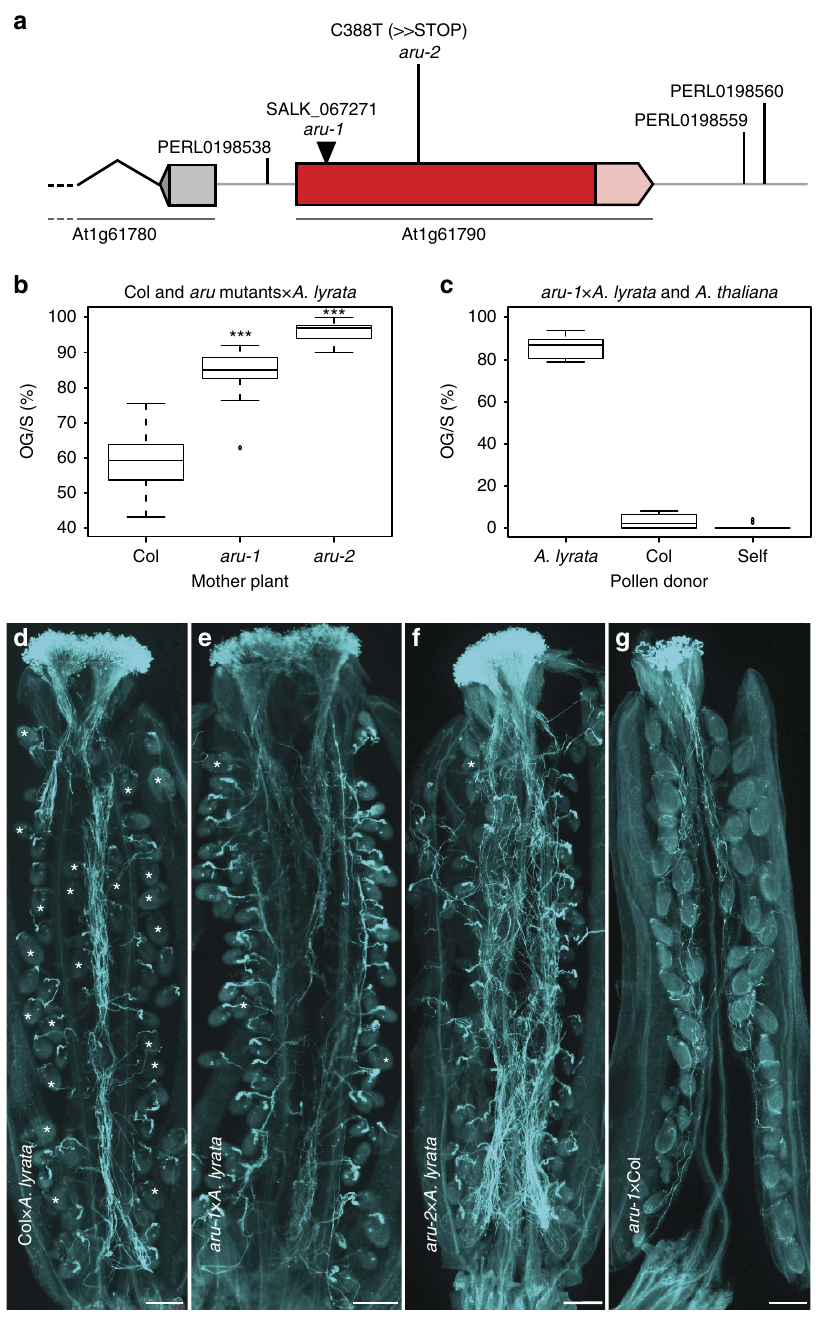
Figure 4 | ARTUMES mutants are impaired in interspecific PT reception. ( a ) Genomic region of ARTUMES (At1g61790) with the two mutant alleles aru-1 and aru-2 , and the surrounding polymorphisms identified by GWAS. ( b ) PT overgrowth of Col-0 wild-type ( n ¼ 28 siliques) and aru mutant plants in interspecific crosses. Both aru mutant alleles show significantly higher proportions of ovules with PT overgrowth per silique (OG/S, Student’s t -test *** P o 0.001; n ¼ 18 and 20 siliques, respectively). ( c ) PTovergrowth of aru-1 in inter- and intraspecific crosses. The mutant is impaired in interspecific crosses with A. lyrata pollen ( n ¼ 9 siliques), but not in intraspecific crosses with Col-0 ( n ¼ 6) or self pollen ( n ¼ 9). ( d ) A silique of Col-0 pollinated with A. lyrata pollen. Ovules with normal PT reception (marked with asterisks) and with PTovergrowth are visible. ( e , f ) aru-1 and aru-2 siliques pollinated with A. lyrata pollen. Both mutant alleles show high proportions of ovules with PT overgrowth in interspecific crosses. Ovules with normal PT reception are marked with asterisks. ( g ) A silique of aru-1 pollinated with intraspecific Col-0 pollen. All ovules display normal PT reception. Scale bars, 250 m